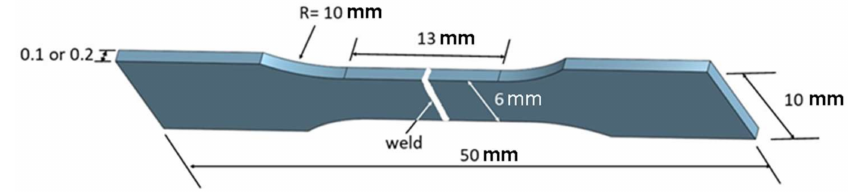
Figure 2. Schematic diagram of the dog-bone sample with dimensions (in